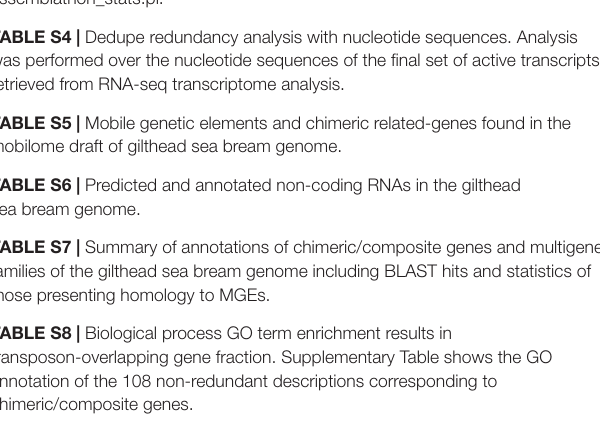
TABLE S4 | Dedupe redundancy analysis with nucleotide sequences. Analysis was performed over the nucleotide sequences of the final set of active transcripts retrieved from RNA-seq transcriptome analysis. TABLE S5 | Mobile genetic elements and chimeric related-genes found in the mobilome draft of gilthead sea bream genome. TABLE S6 | Predicted and annotated non-coding RNAs in the gilthead sea bream genome. TABLE S7 | Summary of annotations of chimeric/composite genes and multigene families of the gilthead sea bream genome including BLAST hits and statistics of those presenting homology to MGEs. TABLE S8 | Biological process GO term enrichment results in transposon-overlapping gene fraction. Supplementary Table shows the GO annotation of the 108 non-redundant descriptions corresponding to chimeric/composite genes. TABLE S9 | Synteny results between gilthead sea bream and related species. TABLE S10 | Tissue-exclusive genes dataset. Homology-based annotation was done according to the gilthead sea bream transcriptome and NCBI non-redundant (Nr) database, and the correspondent Uniprot KB AC/ID was retrieved for each gene. The number of copies is shown in Copy number column. TABLE S11 | Tissue-exclusive duplicated gene list. Results highlights tissue-expression pattern in other animal models: enriched in tissue (red), enriched in tissue and/or other tissues (green), expressed in all tissue (blue), and unclassified (uncolored). A range of colors is shown for the (cid:49) copies between paralog sets ordered by each category. Column Corrected P-val shows the result for the ANOVA (FDR < 0.05) test. TABLE S12 | Pearson correlation coefficients between RNA-seq and real-time qPCR expression values of tissue-exclusive genes. AI-PI, anterior and posterior intestine; WSM, white skeletal muscle; L, liver; S, spleen; G, gills; PCC, Pearson correlation coefficient. 1 P -value obtained in Pearson